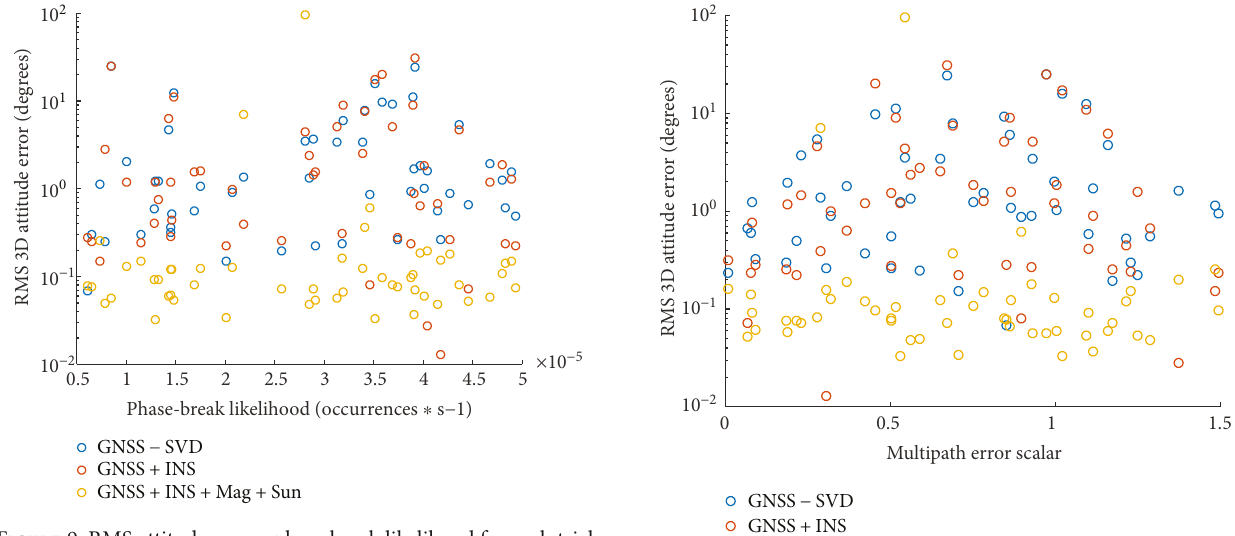
Figure 9: RMS attitude versus phase break likelihood for each